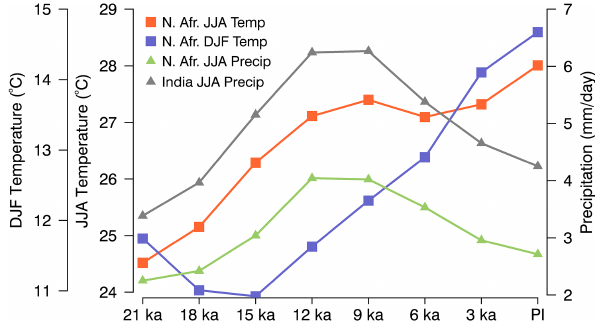
Figure 10. Time evolution of North African and Indian summer monsoons. The North African monsoon region is defined as 12– 30 ◦ N, 20 ◦ W–30 ◦ E and Indian monsoon region is defined as 20– 40 ◦ N, 70–100 ◦ E (Zhao and Harrison,